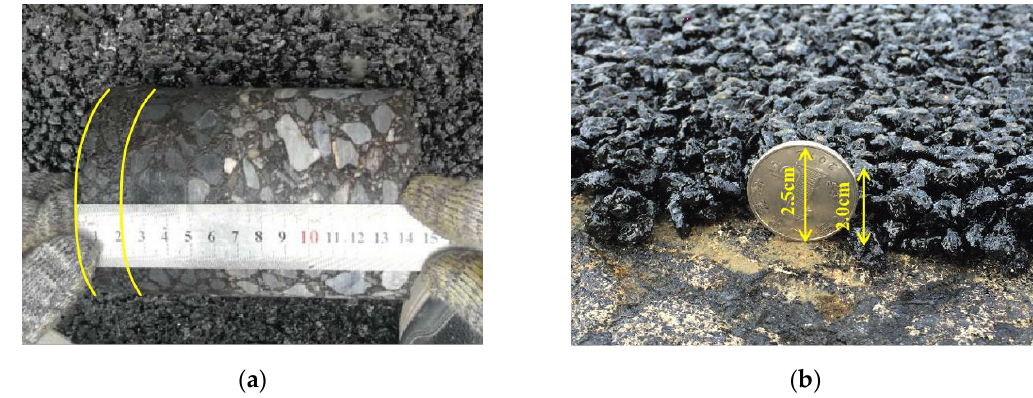
Figure 17. Verification of thickness of ultra-thin overlay: ( a ) Measuring core sample drilled at site; ( b ) Roadside measurement.